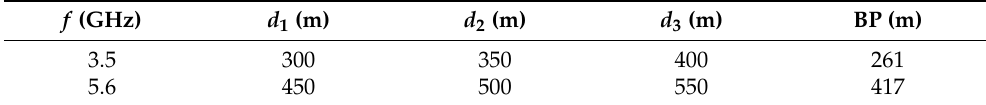
Figure 10. The model and antennas setting ( a ) Cascaded tunnel; ( b ) straight tunnel. The above two models and antenna configurations are imported into Wireless Insite for channel simulations. The simulation parameters are shown in Table 4. According to (2)–(5), the arched tunnel is equivalent to a rectangular tunnel with w = 4.73 m and h = 4.23 m. Then, the BP of each frequency band is calculated by using (1), and three different d are selected for each frequency band using (23), as shown in Table 3. Table 4. BP and d at 3.5 GHz and 5.6 GHz